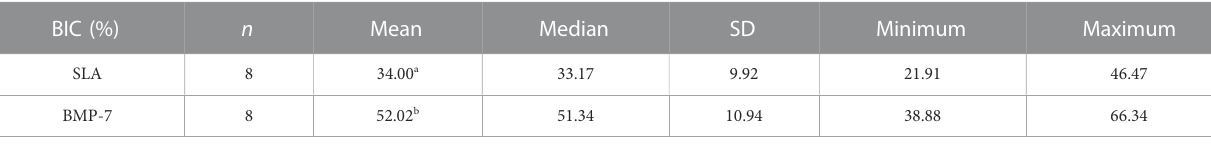
TABLE 1 Descriptive statistics of the BIC (%) histomorphometric parameters. BIC (%)